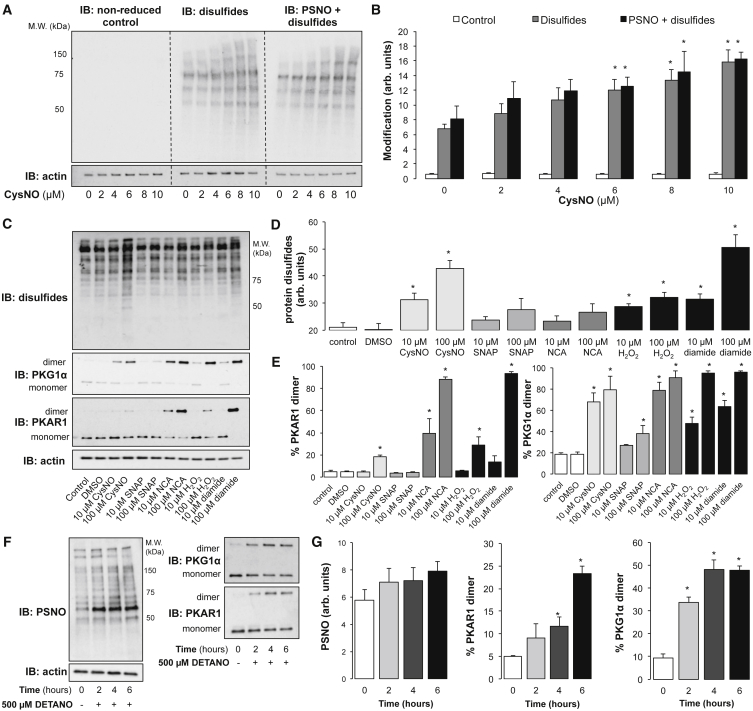
The Major Product of Exogenous or Endogenous Nitrosative Signaling Is Disulfide Formation(A) The double S-nitrosothiol/disulfide switch was used to compare disulfides with combined (PSNO + disulfides) protein oxidation in SMCs after treatment with CysNO for 30 min. A dose-dependent increase in total protein oxidation was observed upon treatment with CysNO.(B) A significant increases in both disulfides and PSNO + disulfides was observed from baseline. There was no statistical difference between the two treatment groups at any concentration of CysNO.(C) Global disulfides and disulfide formation in PKG1α and PKAR1 was measured in SMCs after 5 min treatment with 10 or 100 μM CysNO, SNAP, NCA, H2O2, or diamide.(D) Global disulfides were significantly increased after exposure to both doses of CysNO, H2O2, or diamide.(E) Significant disulfide formation in PKAR1 was induced by 10 μM NCA or 100 μM CysNO, H2O2, or diamide. Significant PKG1α dimerization occurred after exposure to 10 or 100 μM CysNO, NCA, H2O2, or diamide or 100 μM SNAP.(F) PSNO, PKG1α, and PKAR1 disulfide dimer formation was measured in SMCs over a 6-hr treatment with 500 μM DETANO.(G) Although no significant increase in PSNO was observed at any time point, a significant increase in PKAR1 disulfide formation was observed after 4 hr and PKG1α at 2 hr.Data are represented as mean ± SEM; ∗p < 0.05.